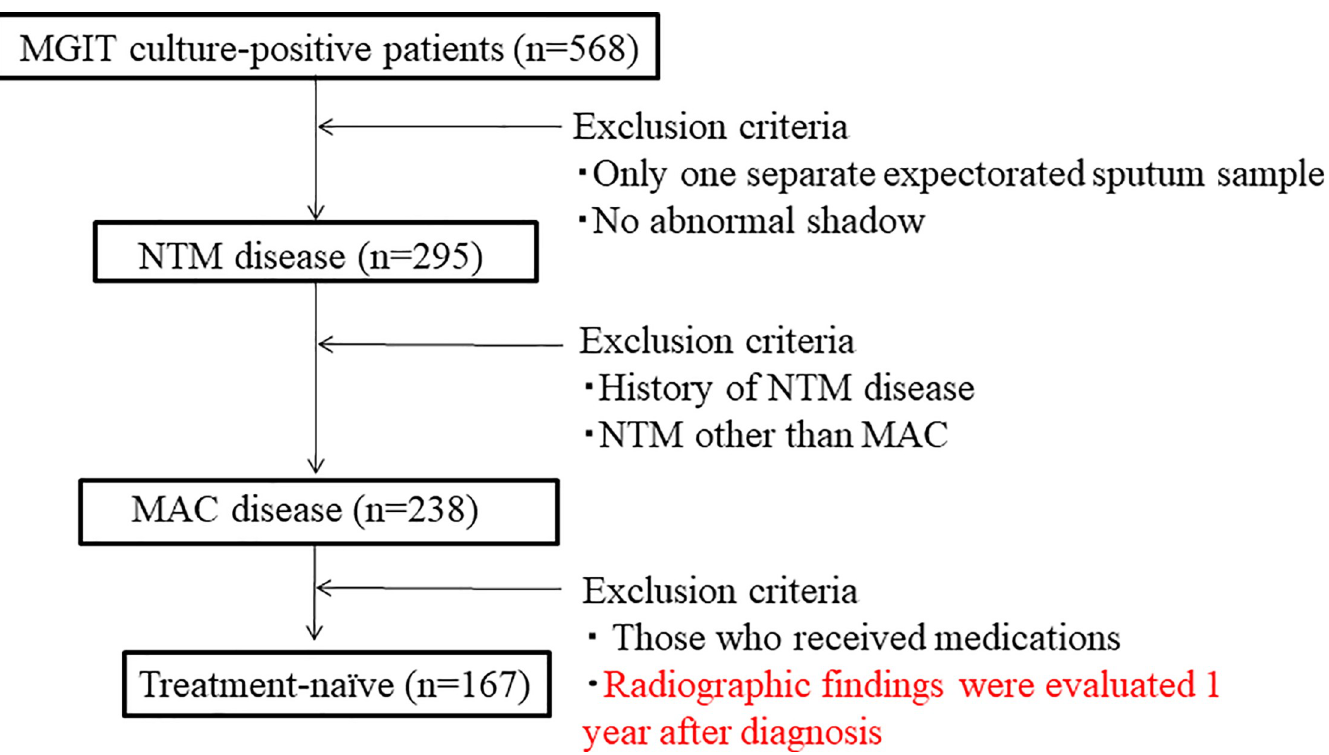
Fig 1. Flow chart of patients diagnosed with pulmonary MAC disease between April 2011 and December 2018. MGIT = mycobacterial growth indicator tube, NTM = nontuberculous mycobacterium, MAC = Mycobacterium avium complex.